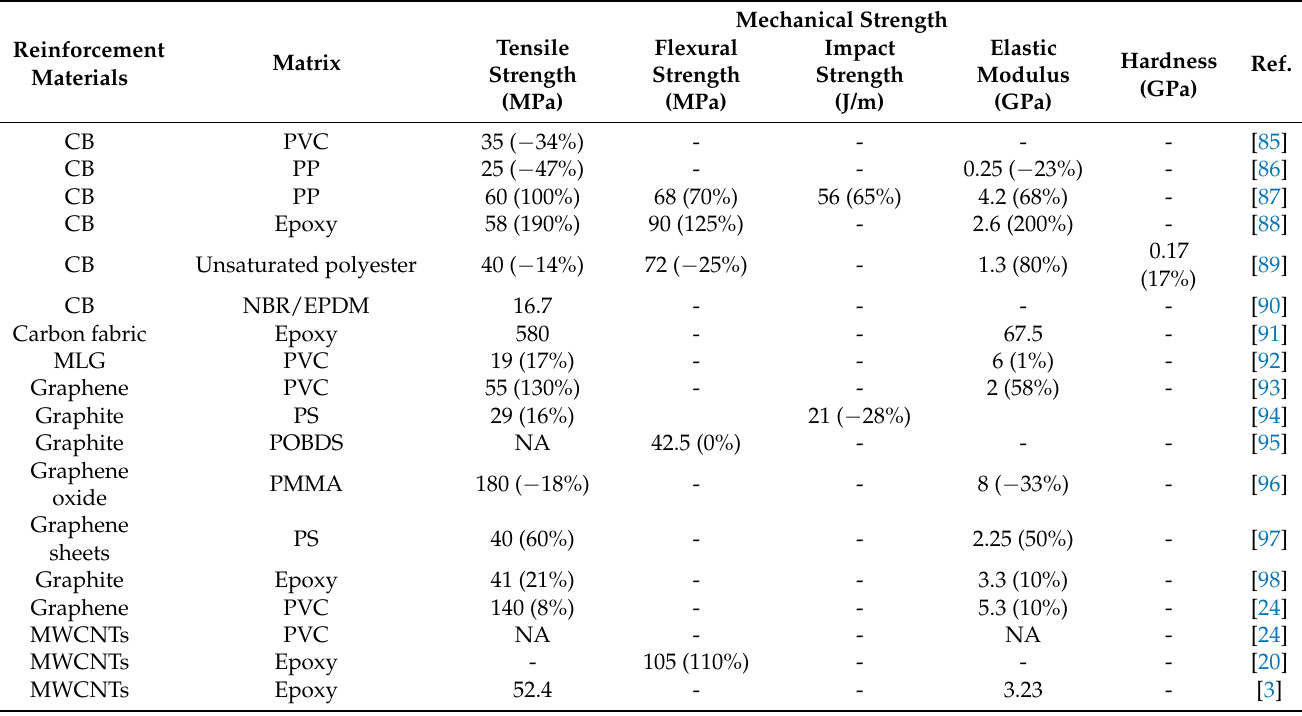
Table 3. Mechanical properties of various carbon-based as reinforcement materials in polymer composites.